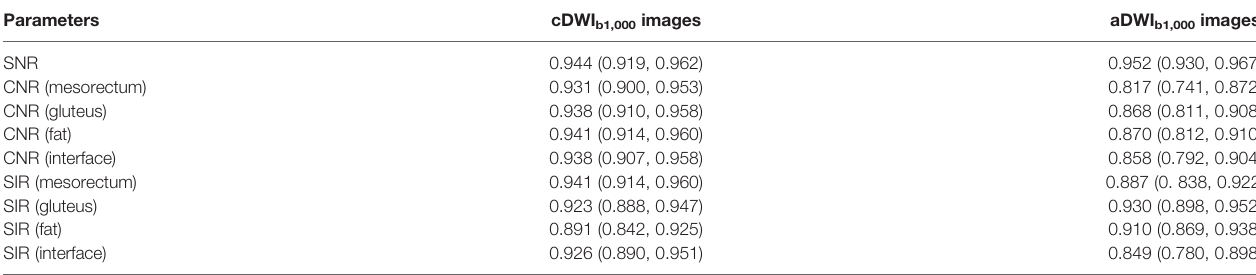
TABLE 5 | Interobserver Variability of Image Quality of DWI b1,000 and aDWI b1,000 images.